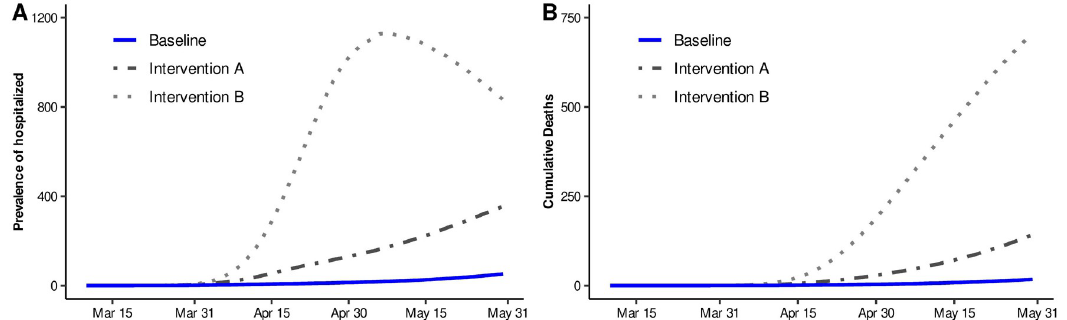
Fig 6. Median estimates for some epidemic curves. Blue solid line represents our baseline dynamics for Scenario 2. Dotted-dashed line represents Intervention A, whose mitigation measures are supposed to start on March 23. Dotted line represents Intervention B, whose mitigation measures are assumed to begin on March 30. A) Prevalence of hospitalized. B) Cumulative deaths.